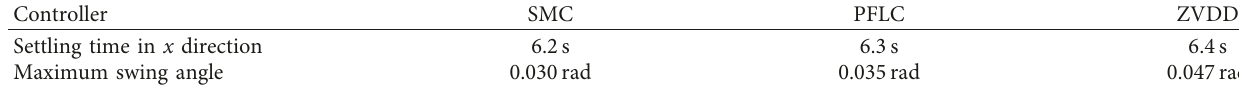
Table 4: Performances of SMC, PFLC, and ZVDD controllers (simulation for l � 0.5m and m � 0.5kg).